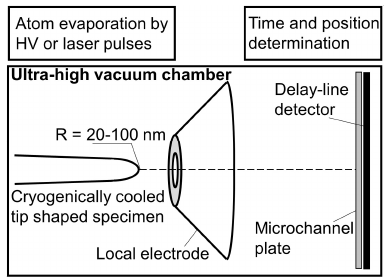
Figure 2. Scheme of the major components present in a local electrode atom probe (LEAP) redrawn after reference [62]. Surface atoms near the tip’s apex are evaporated either by high voltage or